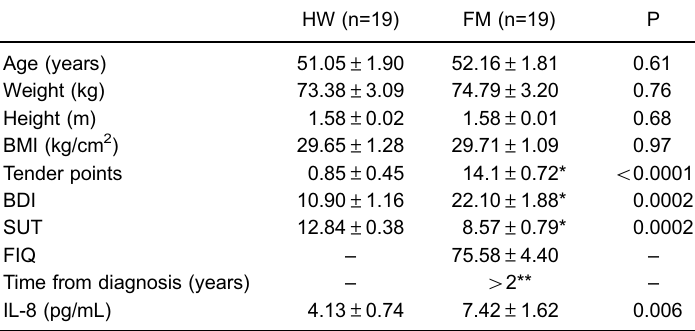
Table 1. Characteristics of study subjects.